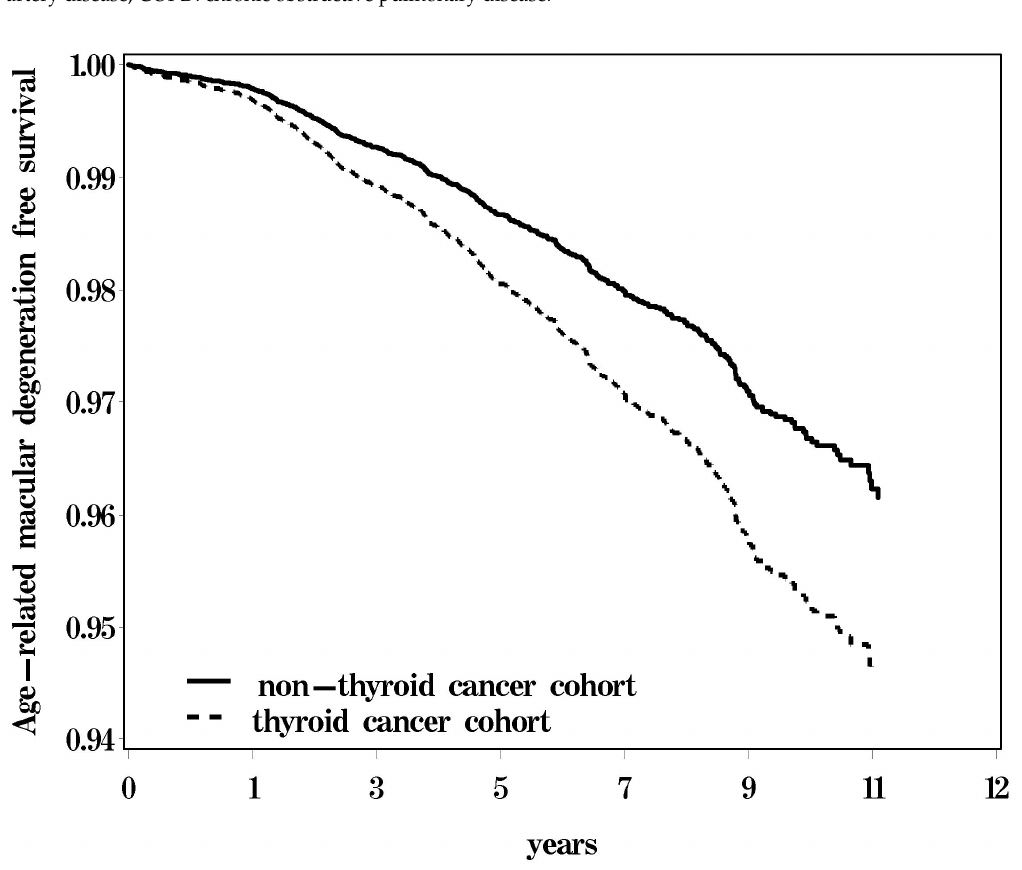
Figure 1. The probability of age-related macular degeneration (AMD)-free survival of the two cohorts.